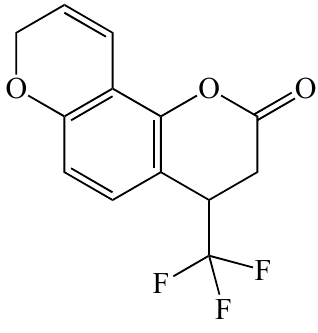
Figure 9. Structure of 4-trifluoromethyl-7,8-pyranocoumarin.